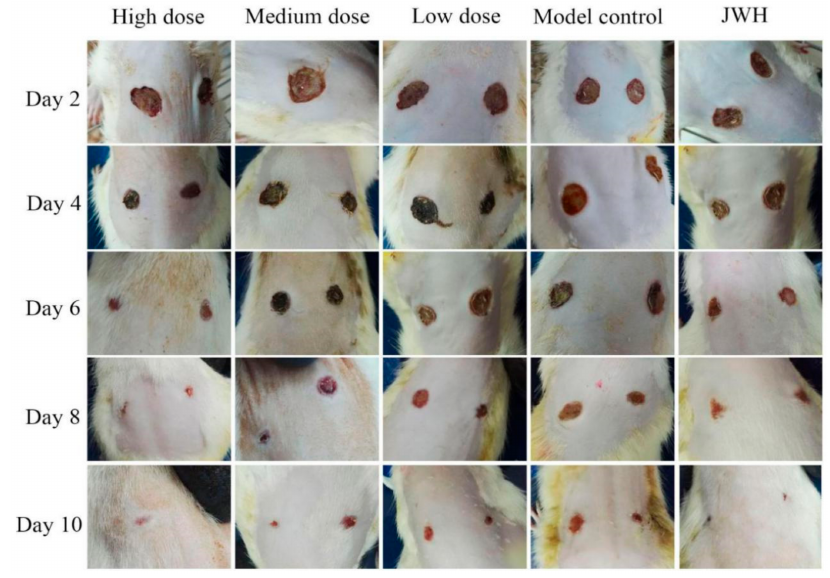
Figure 2. Recovery of wounds at different times. JWH, Jing Wan Hong.